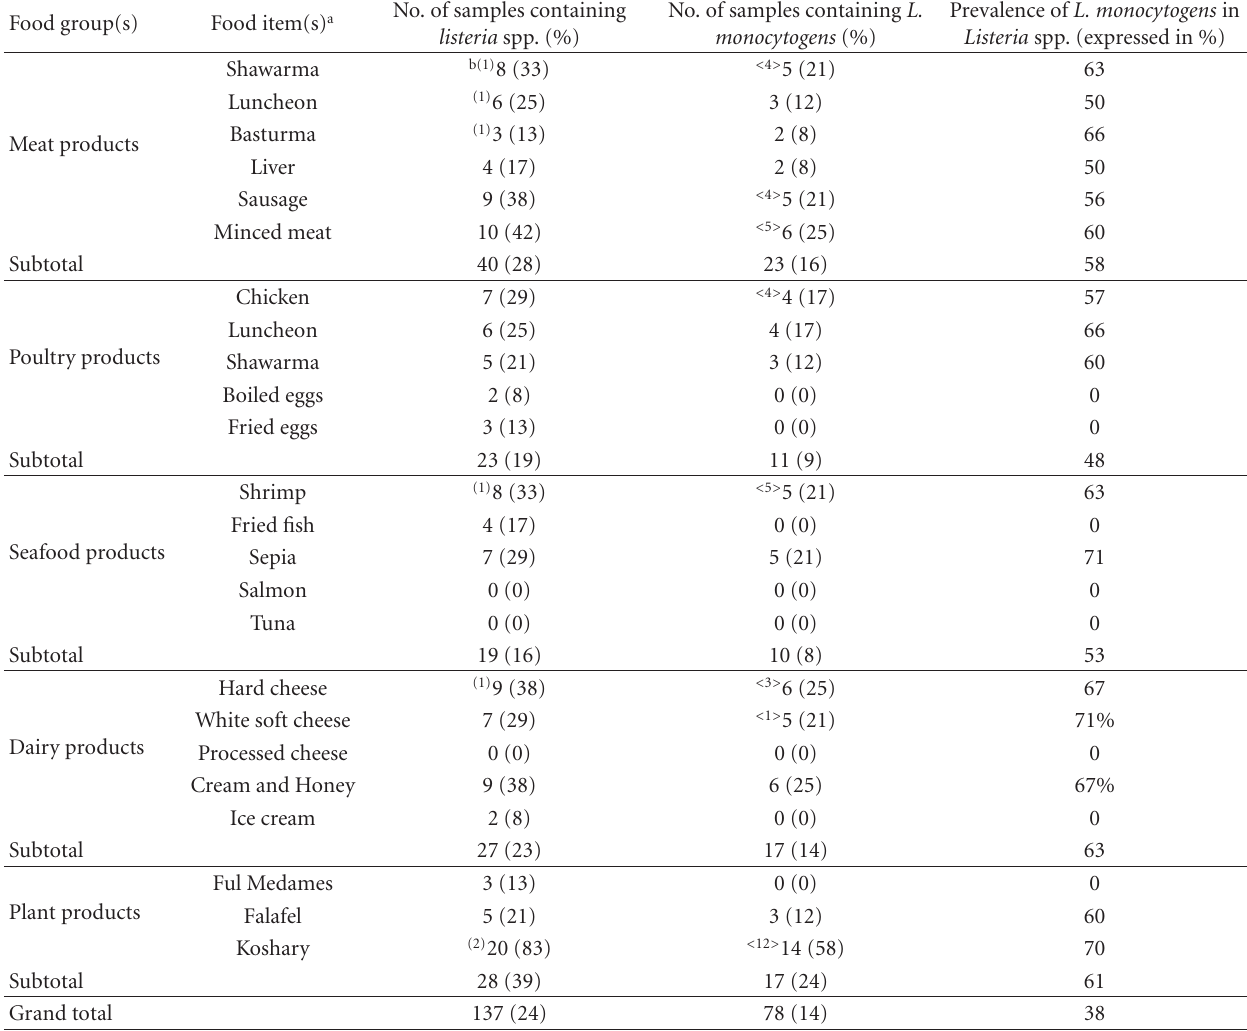
Table 1: Listeria spp. detected in street-vended ready-to-eat foods by plate count method. Food